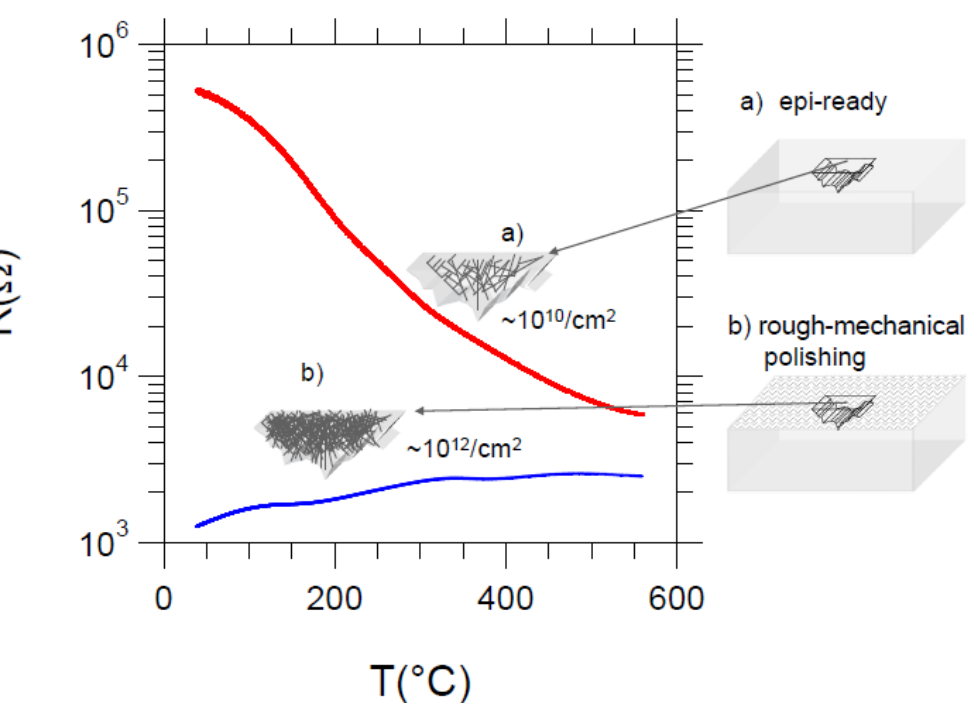
Figure 45. The simultaneous reduction of two pieces (one with original epi-polished surface and one with higher roughness, at T = 550 °C and vacuum − 10 − 7 mbar) from the same SrTiO 3 (100) crystal under UHV conditions shows that the thermal dependence of electrical conductivity of the piece with original epi-polished surface gives semiconducting behavior while in contrast the electrical resistance of the piece of the crystal with the rough surfaces (generated via scratching) reveals the characteristics of metallic conductivity. Note 1: mentioned mechanical preparation of the original (epi-polished surface) leads to the increase of the concentration of dislocations from 4 × 10 9 /cm 2 to higher than 10 12 /cm 2 . Note 2: the thermal reduction of both samples was obtained for an optimal reduction time, namely for the time which allowed reaching the minimum of the resistance curve (for more details please see reference [68]).